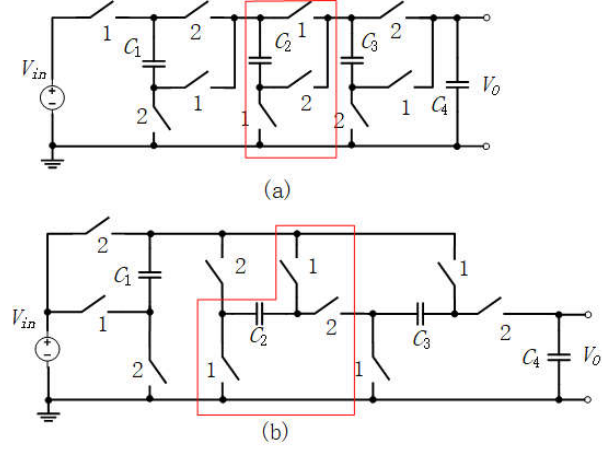
Figure 15. Fibonacci. ( a ) A Fibonacci step-down converter. ( b ) A Fibonacci step-up converter.